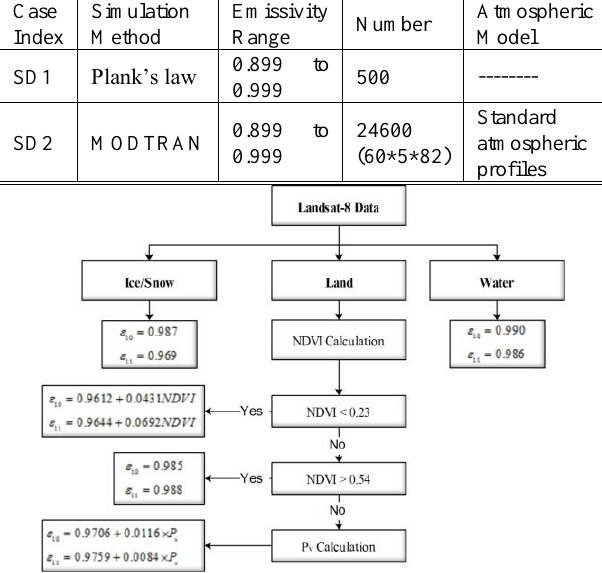
Figure 1 - Flowchart of NDVI-based emissivity estimation for Landsat-8 TIRS bands